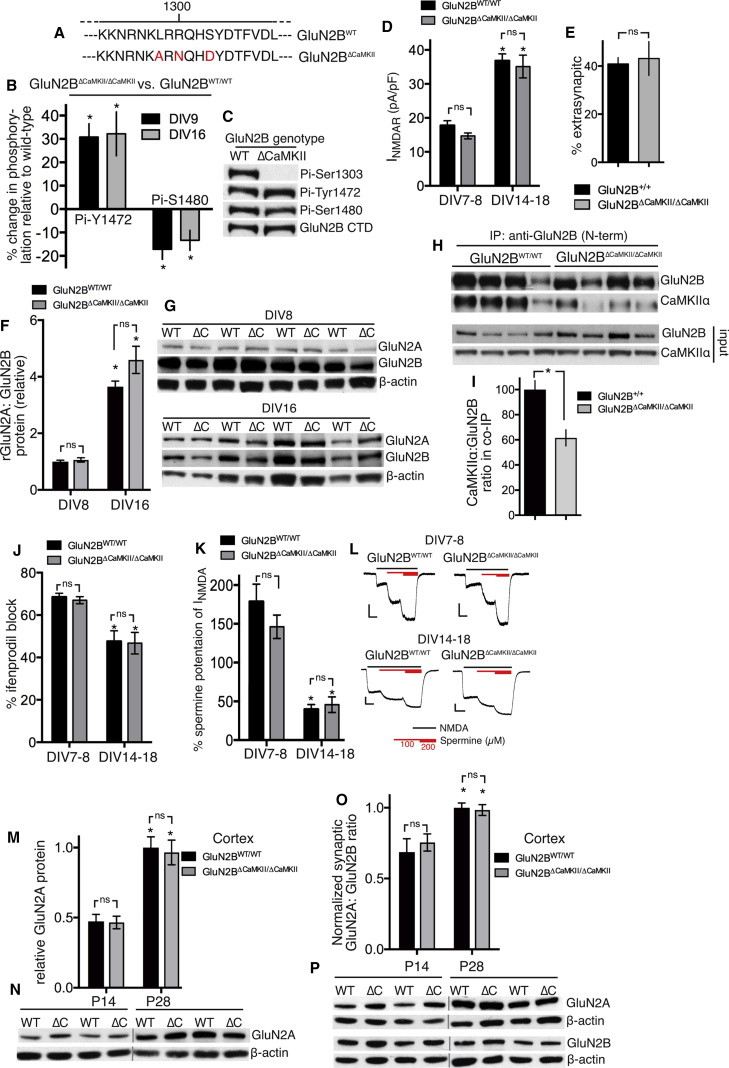
The GluN2B CaMKII Site Is Dispensable for the Developmental Switch In Vitro(A) Schematic of the GluN2BΔCaMKII amino acid changes.(B and C) Altered GluN2B phosphorylation in GluN2BΔCaMKII/ΔCaMKII neurons. Cortical neuronal extracts were prepared and analyzed by western blot with the indicated antibodies, normalized to total GluN2B. (B) shows quantitation (mean ± SEM here and throughout), and (C) shows an example. ∗p < 0.05 versus GluN2B+/+ (n = 4).(D) NMDAR current density at the indicated ages for GluN2BWT/WT and GluN2BΔCaMKII/ΔCaMKII neurons. ∗p < 0.05 versus DIV7 or DIV8 of the same genotype; two-way ANOVA plus Sidak’s post hoc test (GluN2BWT/WT: n = 14 [DIV7 or DIV8], n = 18 [DIV14–18]; GluN2BΔCaMKII/ΔCaMKII: n = 15 [DIV7 or DIV8], n = 17 [DIV14–18]).(E) Extrasynaptic NMDAR currents were measured in GluN2BWT/WT and GluN2BΔCaMKII/ΔCaMKII neurons (n = 8 per genotype).(F and G) GluN2A and GluN2B expression analyzed by western blot at DIV8 and DIV16 for GluN2BWT/WT and GluN2BΔCaMKII/ΔCaMKII neurons. (F) shows quantitation and (G) shows an example. ∗p < 0.05 versus DIV8 of the same genotype; two-way ANOVA plus Sidak’s post hoc test (n = 8).(H and I) Neocortices of GluN2BWT/WT and GluN2BΔCaMKII/ΔCaMKII mice were subjected to immunoprecipitation with an antibody to the N terminus of GluN2B, followed by analysis of GluN2B and CaMKIIα content. (H) shows an example and (I) shows quantitation. ∗p < 0.05; n = 8 per genotype.(J) Percentage blockade of NMDAR currents by ifenprodil (3 μM) at the indicated stages for GluN2BWT/WT and GluN2BΔCaMKII/ΔCaMKII neurons. ∗p < 0.05 versus DIV7 or DIV8 of the same genotype; two-way ANOVA plus Sidak’s post hoc test (GluN2BWT/WT: n = 14 [DIV7 or DIV8], n = 18 [DIV14–18]; GluN2BΔCaMKII/ΔCaMKII: n = 15 [DIV7 or DIV8], n = 17 [DIV14–18]).(K and L) Percentage potentiation of NMDAR currents by 100 μM spermine was measured at the indicated stages for GluN2BWT/WT and GluN2BΔCaMKII/ΔCaMKII neurons. ∗p < 0.05 versus DIV7 or DIV8 of the same genotype; two-way ANOVA plus Sidak’s post hoc test (GluN2BWT/WT: n = 13 [DIV7 or DIV8], n = 18 [DIV14–18]; GluN2BΔCaMKII/ΔCaMKII: n = 18 [DIV7 or DIV8], n = 14 [DIV14–18]). (K) shows quantitation and (L) shows example traces; scale bar: 200 pA/2 s.(M and N) Neocortical extracts from P14 and P28 mice were analyzed for GluN2A expression, normalized to β-actin. (M) shows quantitation and (N) shows an example. ∗p < 0.05 versus P14 of the same genotype; two-way ANOVA plus Sidak’s post hoc test (n = 8).(O and P) Post-synaptic density (PSD) extracts from P14 and P28 mice of the indicated genotype were analyzed for GluN2A and GluN2B expression, normalized to β-actin, and the ratio calculated. (O) shows quantitation and (P) shows an example. ∗p < 0.05 versus P14 of the same genotype; two-way ANOVA plus Sidak’s post hoc test (n = 8).